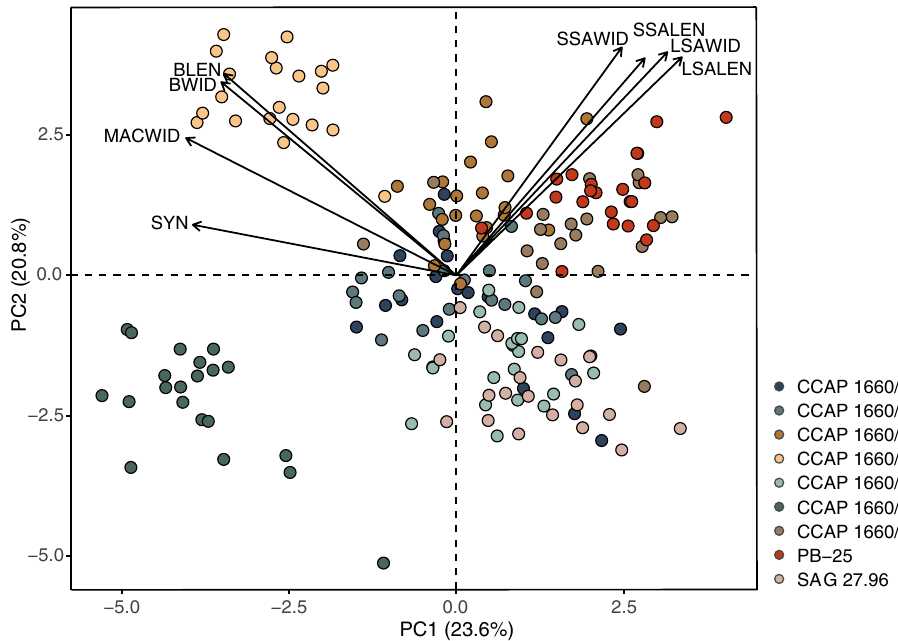
Figure 8. PCA of morphometric data of Paramecium bursaria strains. Only the top eight contributing variables are